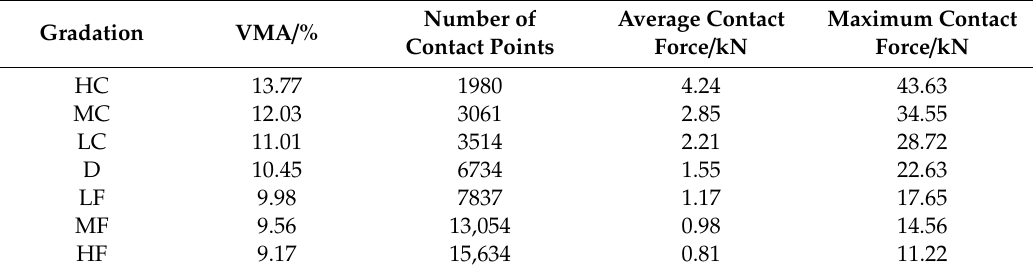
Table 7. Mechanical characteristics of asphalt mixtures.